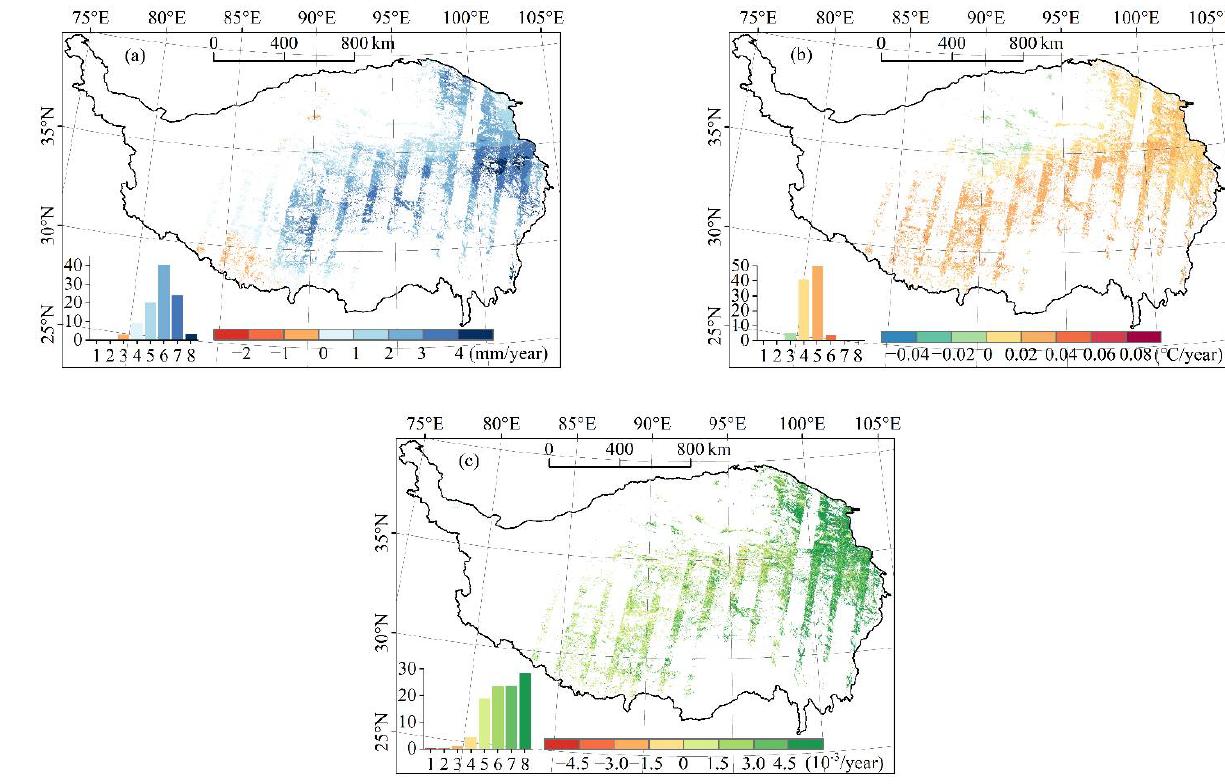
Figure 3. Temporal trends (defined as the slope of the linear regression of the annual variables against the year) in ( a ) growing season precipitation (P GS ), ( b ) growing season temperature (T GS ), and ( c ) growing season NDVI (NDVI GS ). The insets show the percentage of pixels in each interval of the mapped variable.